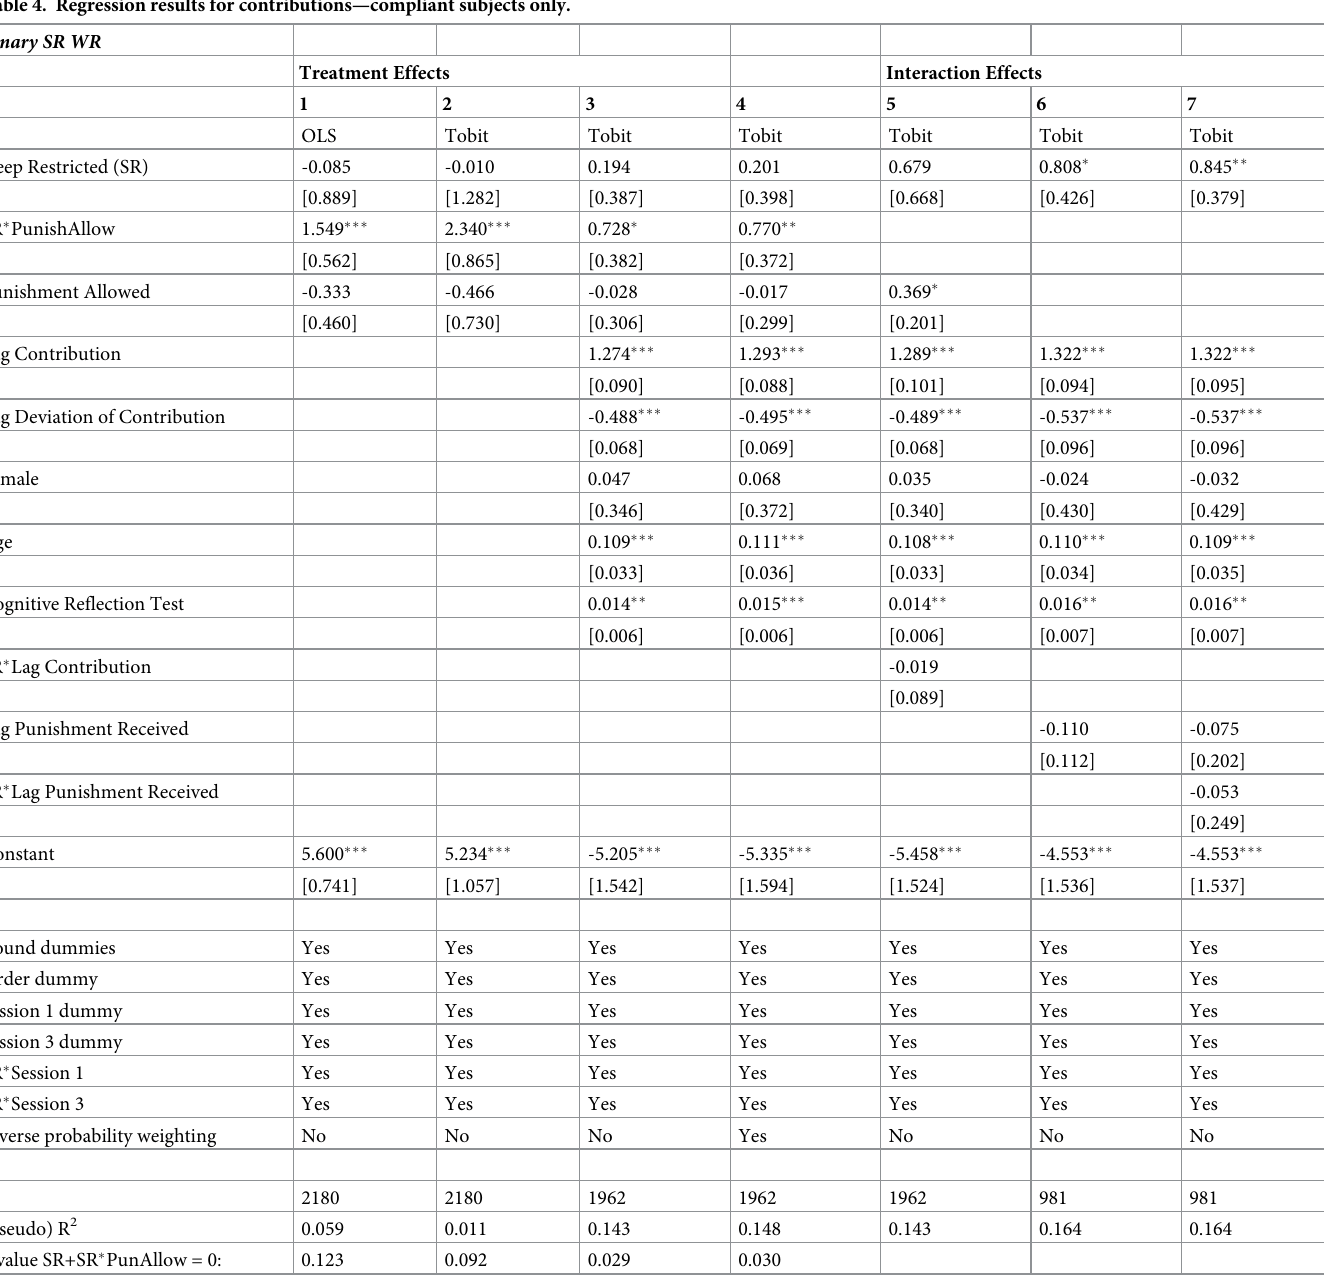
Table 4. Regression results for contributions—compliant subjects